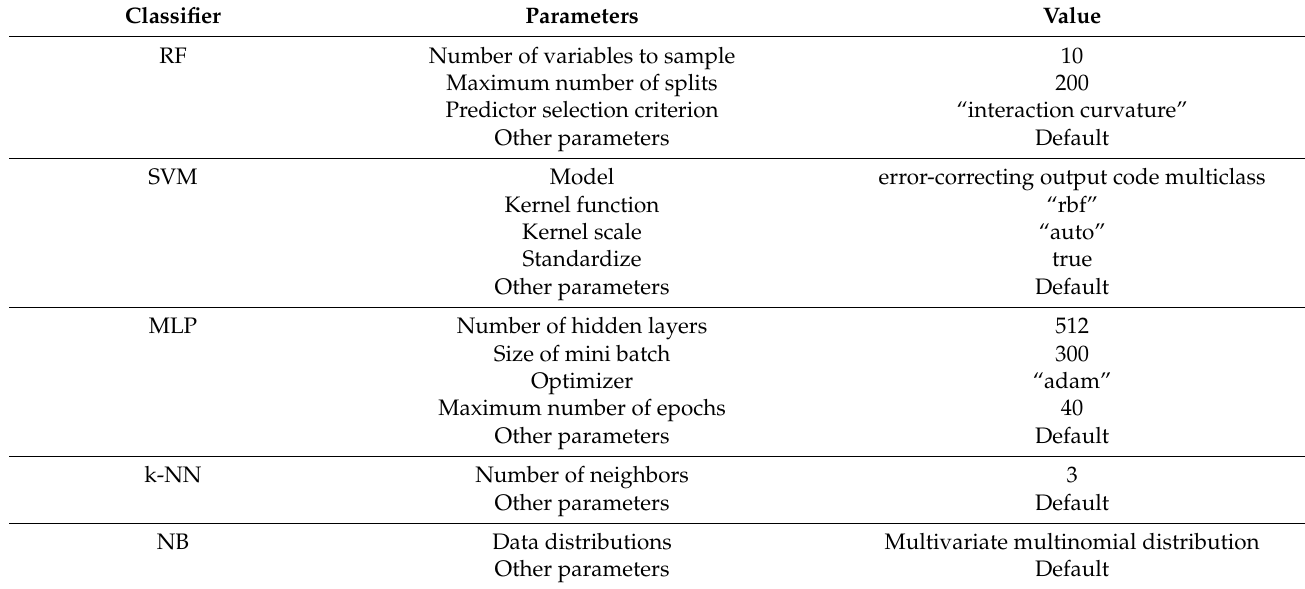
Table 1. Summary of configurations of